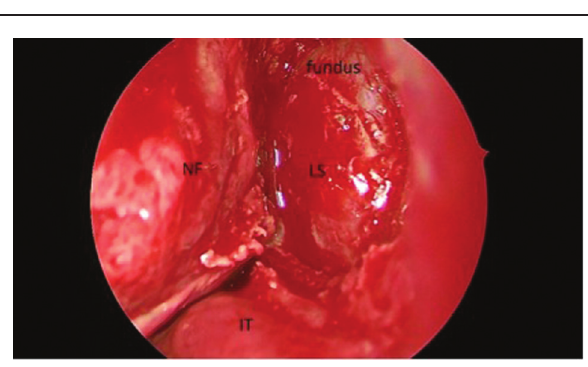
Complete exposure of lacrimal sac after using micro-drill. IT: inferior turbinate, LS: lacrimal sac, NF: nasal flap, fundus of lacrimal sac.